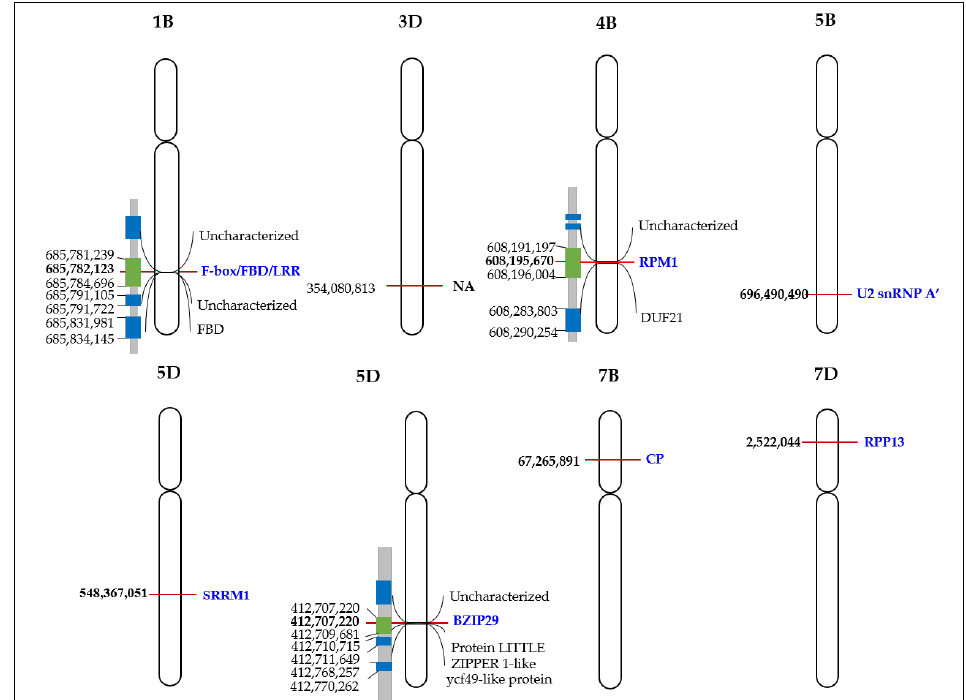
Figure 4. Physical map of the location of eight SNPs and related gene Triticum aestivum associated with AX level. The left and right side show the position and SNP for each locus, respectively. Candidate genes are named in blue. F-box/FBD/LRR = F-box/FBD/LRR-repeat protein; FBD = FBD-associated F-box protein ; RPM1 = disease resistance protein RPM1; DUF21 = DUF21 domain-containing protein; U2 snRNP A′ = U2 small nuclear ribonucleoprotein A′ -like; SRRM1 = serine/arginine repetitive matrix protein 1-like; BZIP29 = bZIP transcription factor 29-like; CP = carboxypeptidase; RPP13 = disease resistance protein RPP13 .